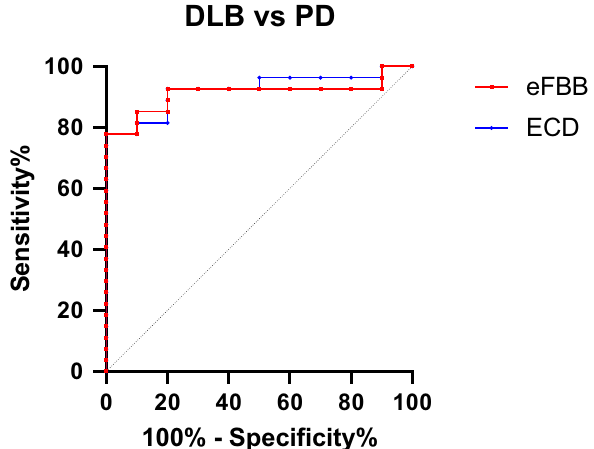
Figure 6. Discriminating power of perfusion imaging. The ROC curve for discriminating PD from DLB (AUC = 0.922 for ECD SPECT, 0.911 for eFBB PET). Abbreviations AUC, area under the curve; DLB, Dementia with Lewy body disease; ECD SPECT, Tc-99m ethyl cysteinate dimer single photon emission computed tomography; eFBB PET, early-phase F-18 Florbetaben positron emission tomography; PD, Parkinson’s disease; ROC, receiver operating